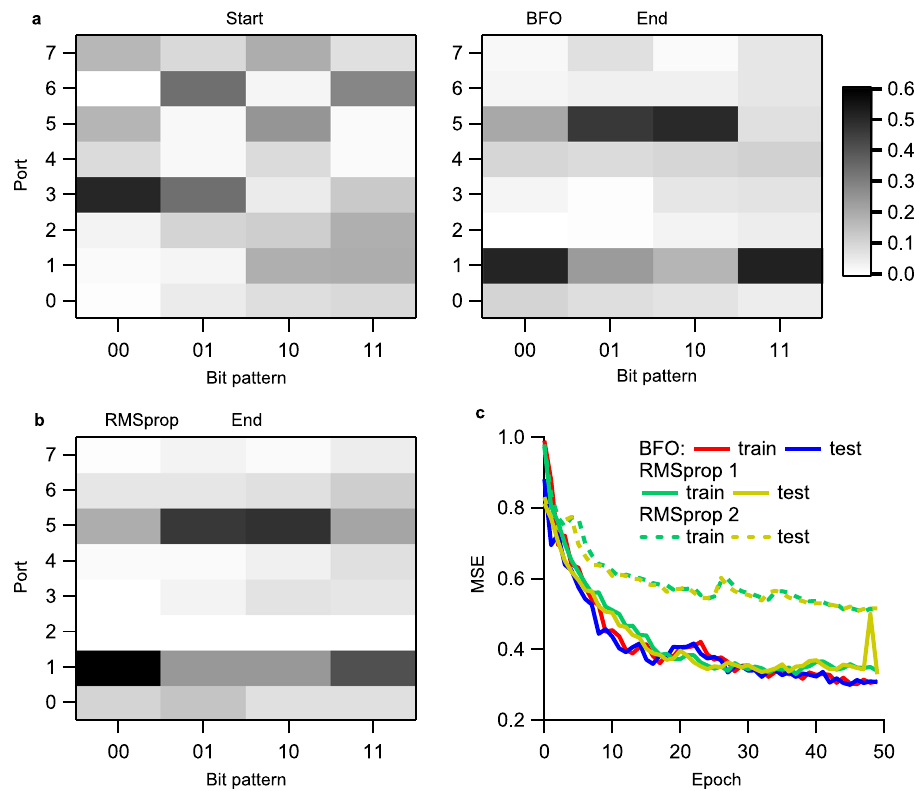
Fig. 3 XOR (exclusive OR) separation experiment. a Measured optical power map y = { p i / Σ p i } (normalized output power) before and after BFO training. p i denotes the optical power at the port i . BFO: bacterial foraging optimization. b Measured power map after RMSprop training. RMSprop: root mean square propagation optimizer. All maps have the same scale. c Experimental MSE error versus the training epoch for both BFO and RMSprop algorithms. RMSprop cases 1 and 2 use Δ V = 0.088 V and 0.044 V, respectively. The train and test both use the same 2-bit patterns (samples), and the test is veri fi ed after every-epoch training. Source data are provided as a Source Data fi